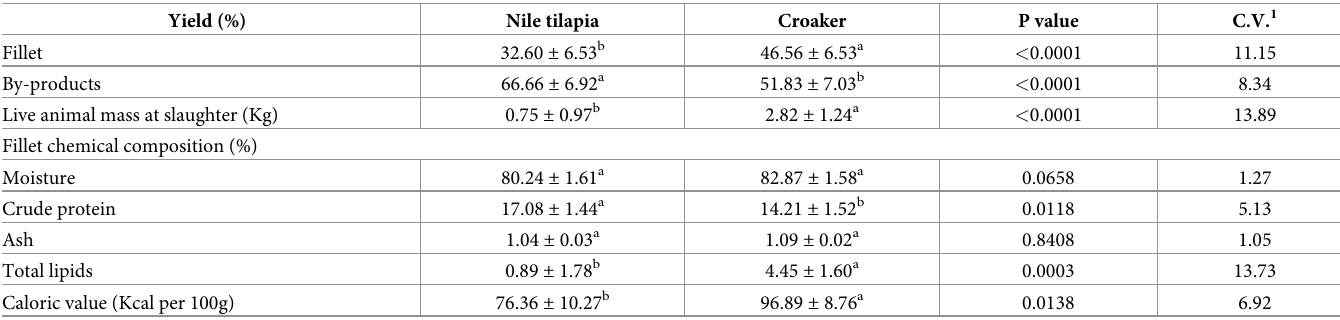
Table 1. Yield and chemical composition of Nile tilapia and croaker